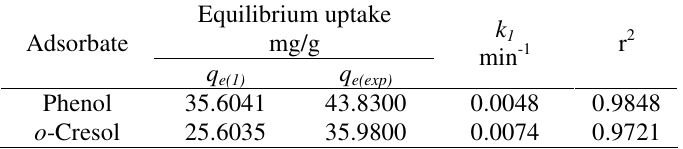
Table 3. First order parameters for the adsorption of phenols on